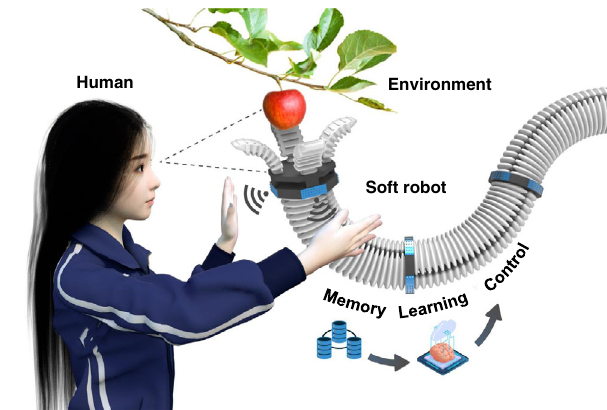
Fig. 1 | A depiction of the principle of touchless human-soft robot interaction basedon fl exiblesmartskin. Humanscan “ teach ” therobottoaccomplishvarious tasks by manipulating the robot in a touchless